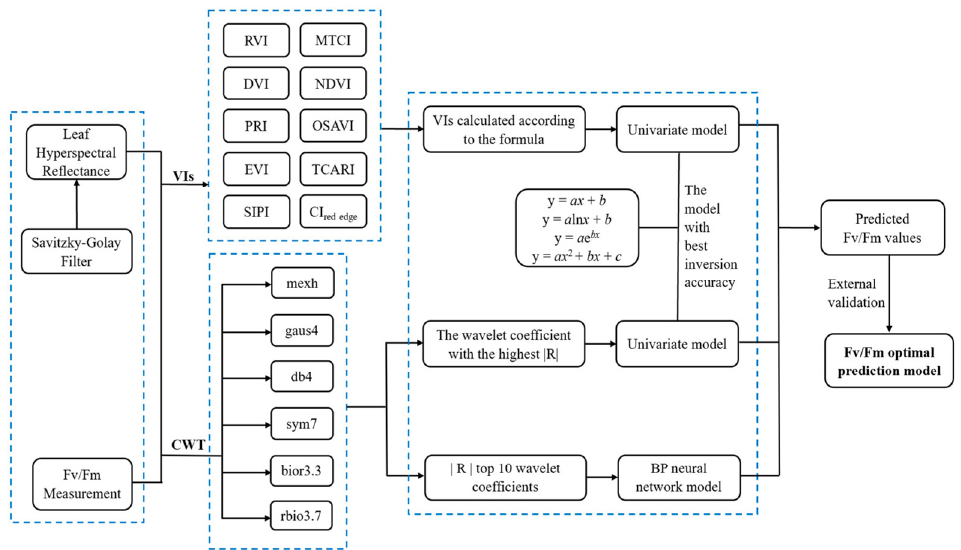
Figure 2. The overall flow chart of data processing. (RVI: Ratio Vegetation Index, DVI: Difference Veg- etation Index, PRI: Photochemical Reflectance Index, EVI: Enhanced Vegetation Index, SIPI: Structure Insensitive Pigment Index, MTCI: MERIS terrestrial chlorophyll Index, NDVI: Normalized Differ- ence Vegetation Index, OSAVI: Optimization Soil Adjusted Vegetation Index, TCARI: Transformed Chlorophyll Absorption in Reflectance Index, CI red edge : Red edge chlorophyll